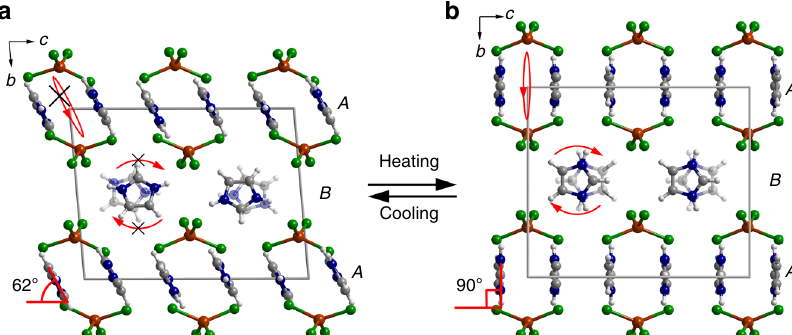
Fig. 1 Crystal structures of 1 at different temperatures. The basic unit of 1 comprises two imidazole (Himd + ) cations and one discrete CuCl 4 2 − dianion that possesses a heavily distorted tetrahedral geometry. a The crystal structure of 1 at 123 K. At this temperature, the Himd + cation is frozen in a ordered state with a dihedral angle φ of 62° relative to the crystallographic (010) face. b The crystal structure of 1 at 393 K. In the HTP, the Himd + cations become rotationally disordered in the molecular plane and the dihedral angle φ shifts to 90°. The Himd + cations in layers A and B are approximately parallel to the crystallographic (001) and (100) faces, respectively. Cu, brown; Cl, green; N, blue; C, gray;